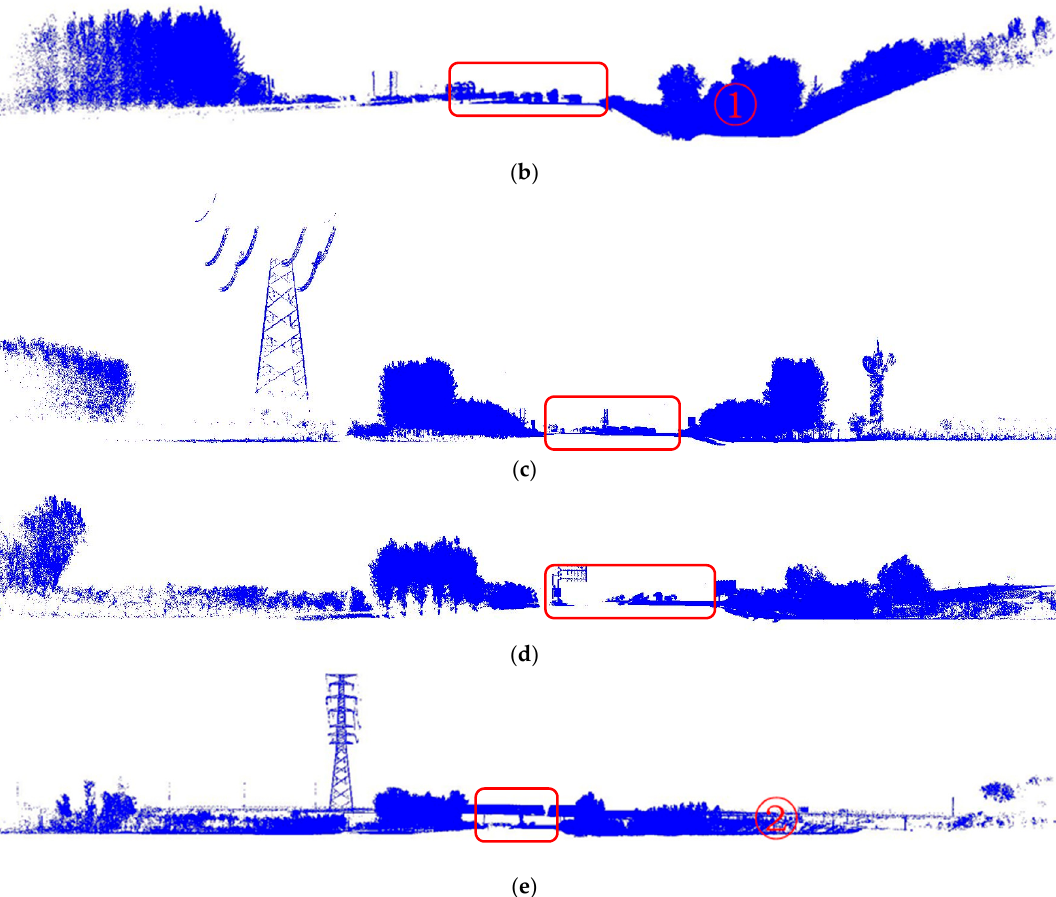
Figure 2. Cross-section views of the five datasets: ( a ) Subset 1; ( b ) Subset 2; ( c ) Subset 3; ( d ) Subset 4; ( e ) Subset 5. Roads are inside the red boxes in ( a – e ). Table 1. The details of the five subset datasets.